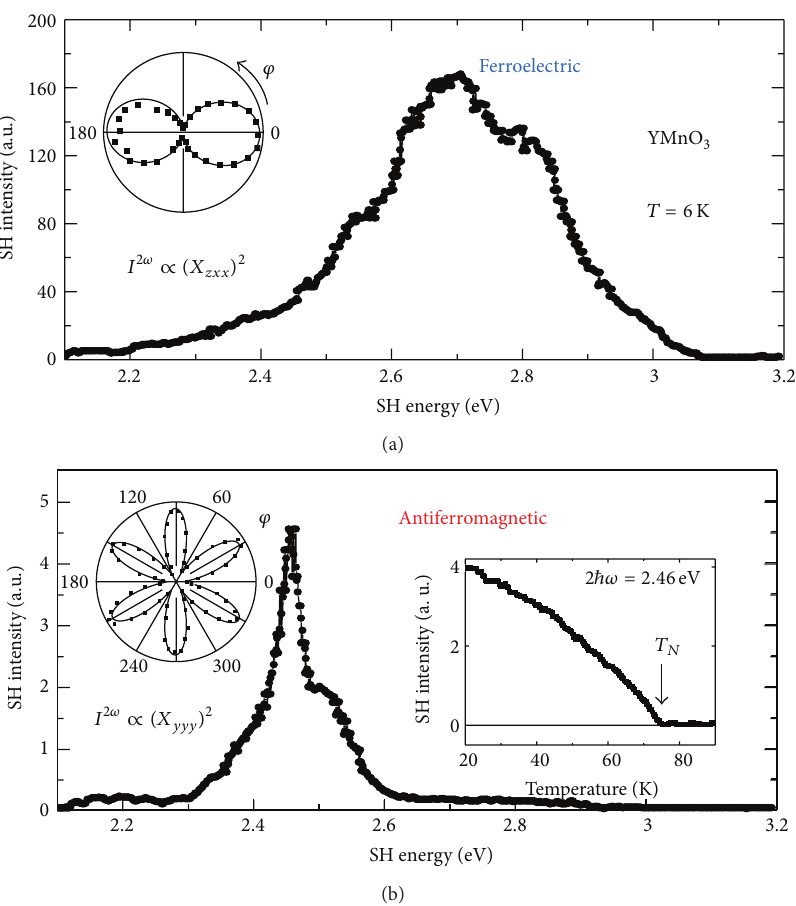
Figure 6: SHG spectra of YMnO 3 due to (a) the ferroelectric ordering and (b) antiferromagnetic ordering; inset: temperature dependence of the SHG intensity of 2.46 eV [34]. Reprinted figure with permission from Fr¨ohlich et al. [34]. Copyright (1998) by the American Physical